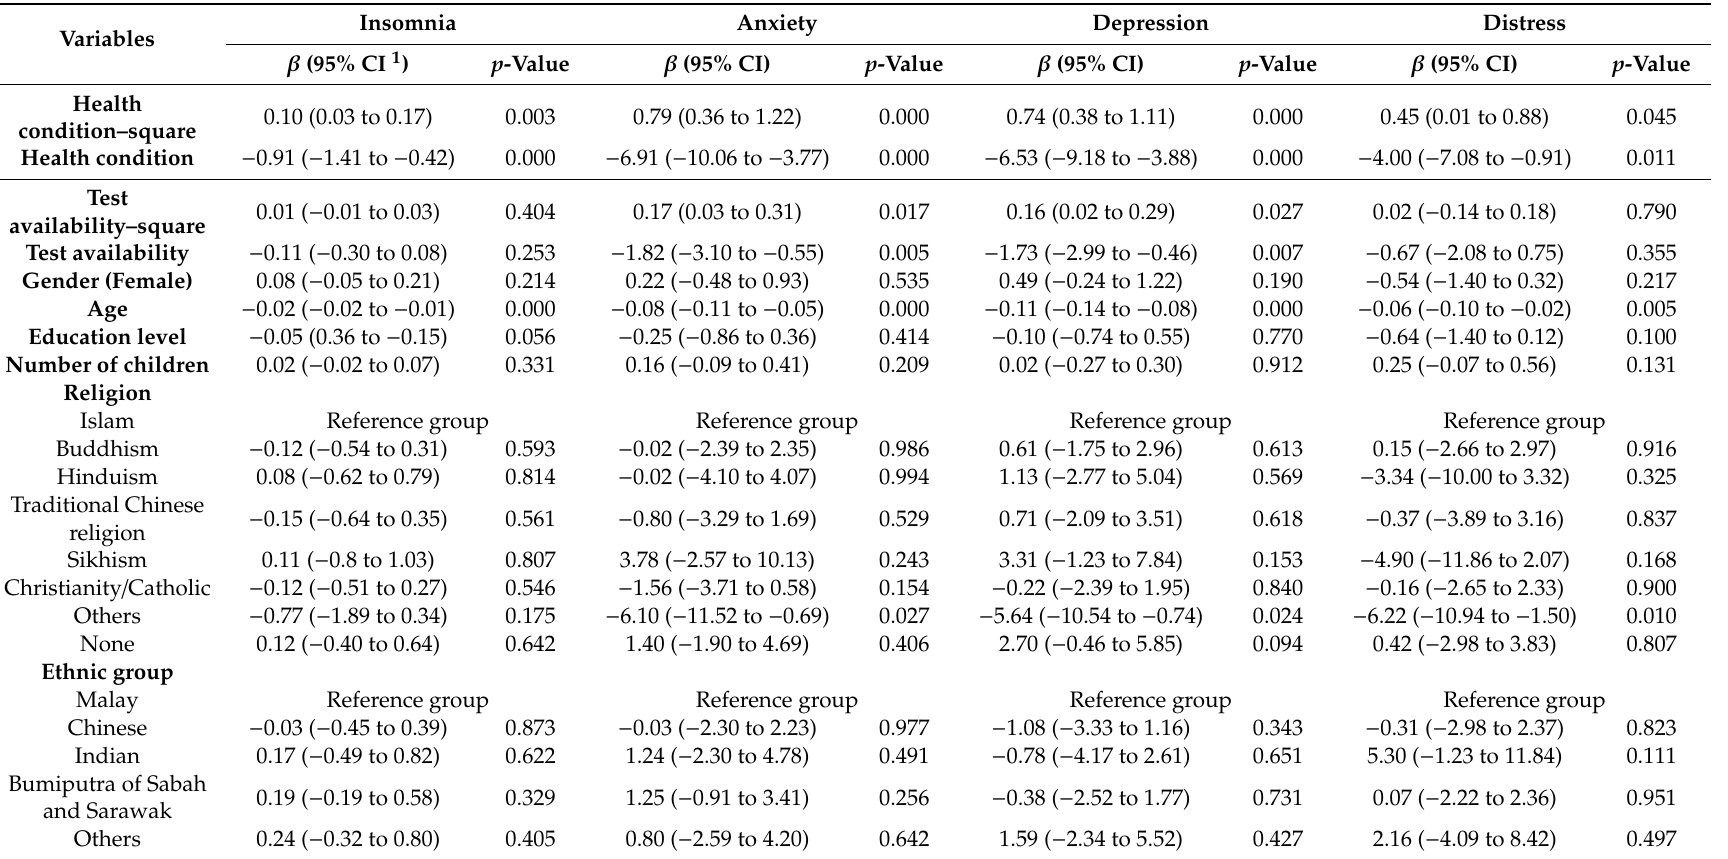
Table 2. Predictors of adults’ insomnia, anxiety, depression and distress by regression analyses ( n =